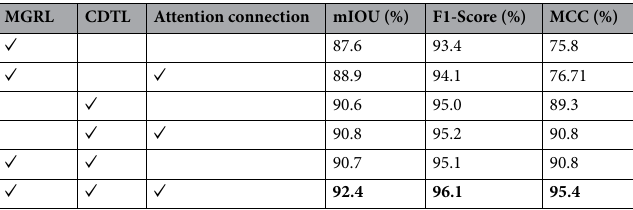
Table 6. The performance of the model using various combinations. The results are best when CDTL, MGRL, and attention connections are used in combination. Best results are shown in [bold].